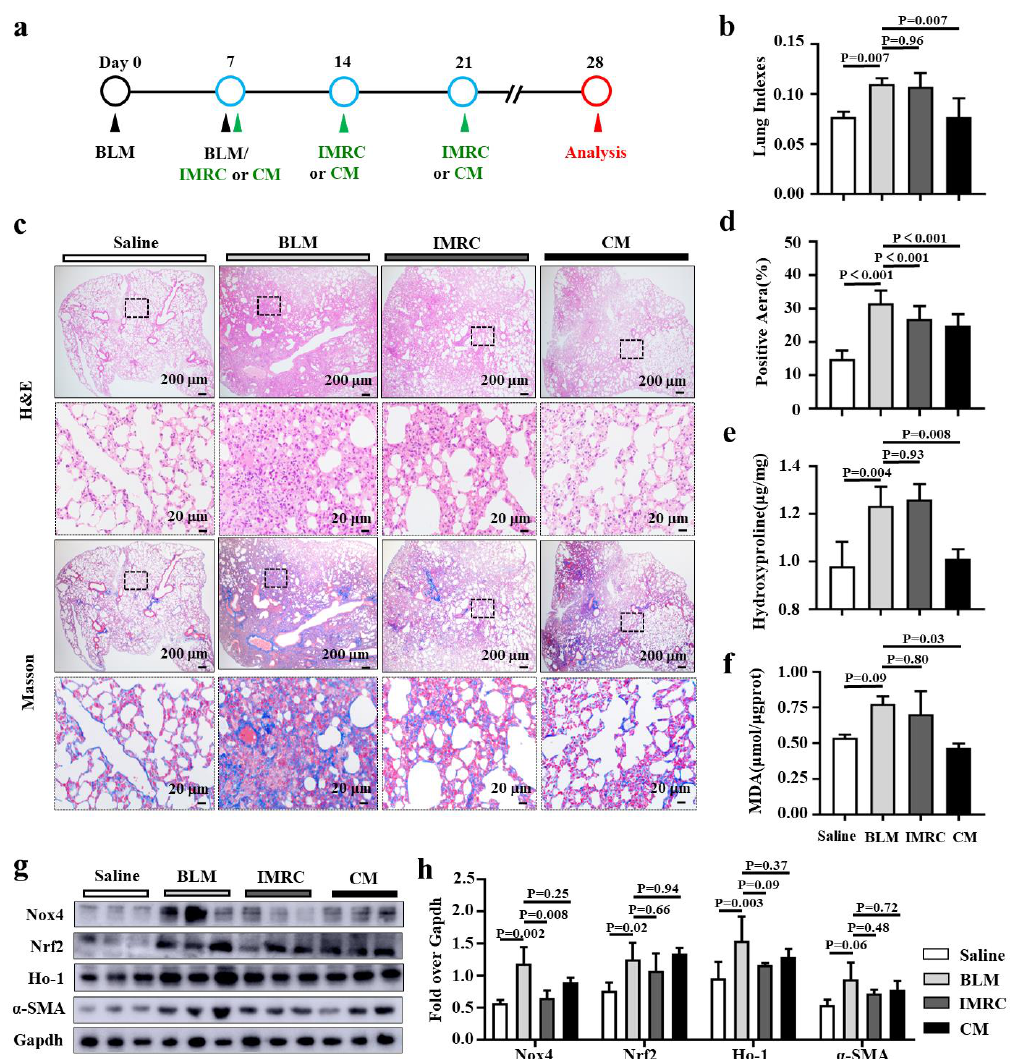
Figure 5. hESC-MSC-IMRC-CM alleviates the progression of pulmonary fibrosis in mice. ( a ) Sche- matic illustration shows the experimental workflow for treatments of late-stage of PF disease in the BLM-induced PF mouse model. C57BL/6 mice were challenged with BLM via the laryngotracheal route at day ( d ) 0 and d7. A 200 μL sample of saline containing 3 × 10 6 cells of hESC-MSC-IMRCs or 200 μL hESC-MSC-IMRC-CM was administrated via tail vein injection at d7, d14, and d21 after the